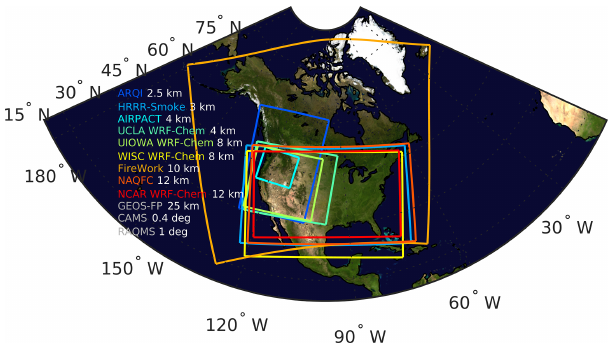
Figure 1. Map of forecast domains for all regional models included in this study. The horizontal grid spacings of the models are la- beled in white (see also Table 1). Note that the domains of the three global forecasting systems, GEOS-FP, CAMS, and RAQMS, are not